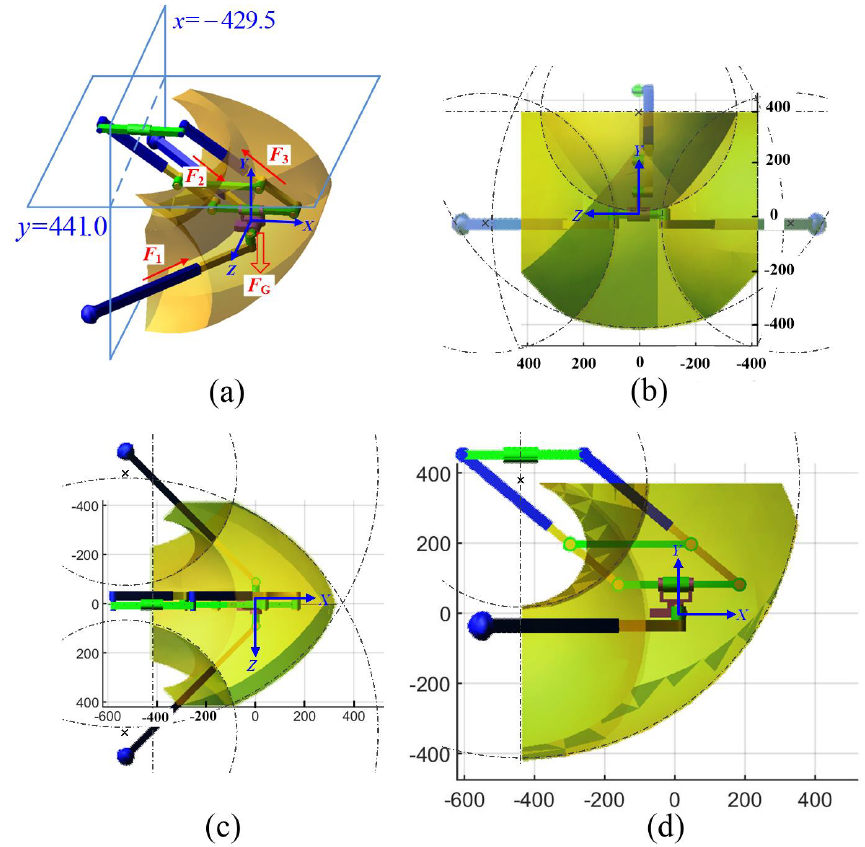
Figure 10. Workspace of the moving platform: (a) oblique view, (b) front view, (c) top view, (d) side view.